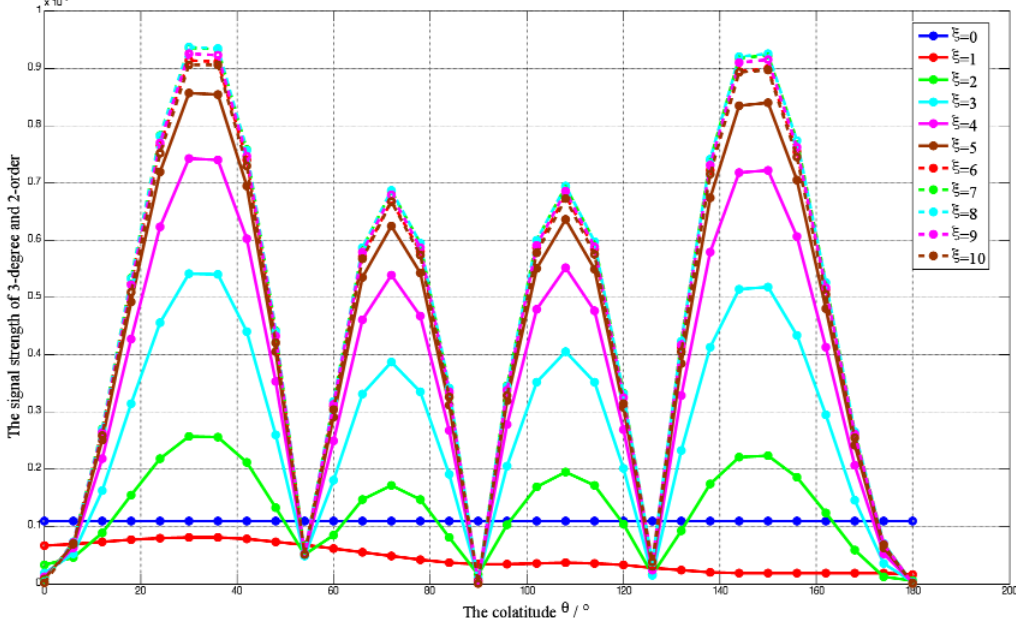
Figure 6. The signal strength of third-degree and second-order spherical harmonics at different co-latitudes (longitude, m = r /4).